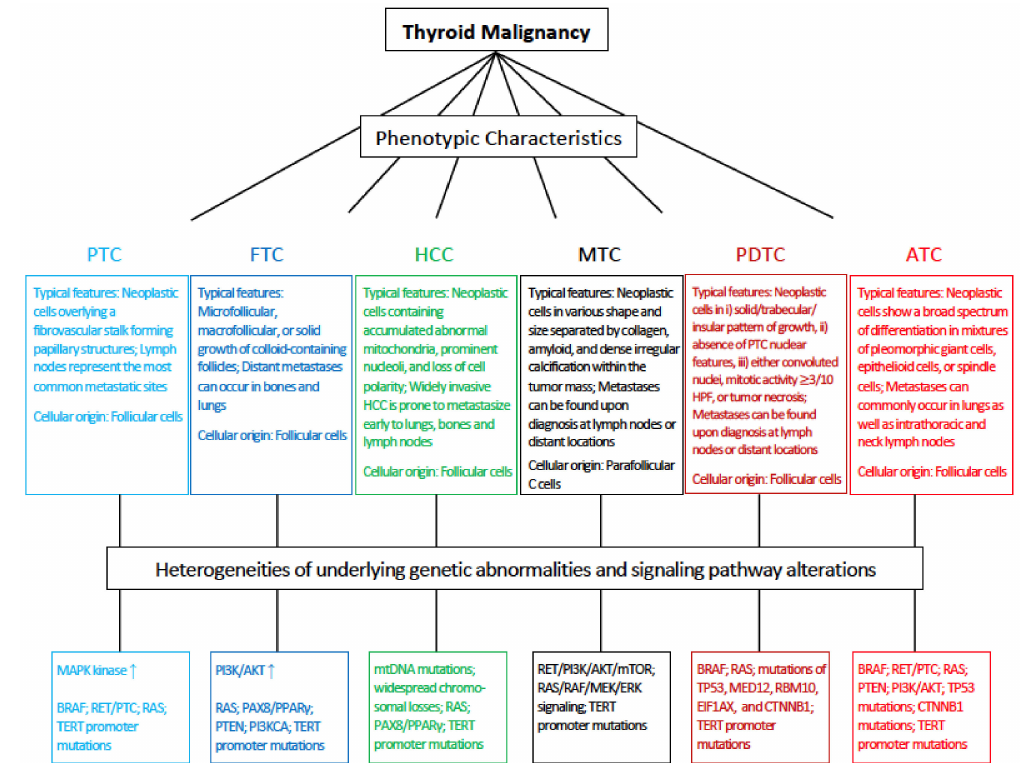
Figure 1. Overview of the phenotypic characteristics and underlying mechanisms of thyroid carcinomas. There are five histologic types of thyroid cancers with variably morphological features. Heterogeneous genetic abnormalities and signaling pathway alterations contribute to the phenotypic variations. PTC: papillary thyroid carcinoma; FTC: follicular thyroid carcinoma; HCC: Hürthle cell carcinoma; MTC: medullary thyroid carcinoma; PDTC: poorly differentiated thyroid carcinoma; ATC: anaplastic thyroid carcinoma; HPF: high power microscopic fields; MED12: mediator complex subunit 12; RNA-binding motif 10; EIF1AX: Eukaryotic Translation Initiation Factor 1A